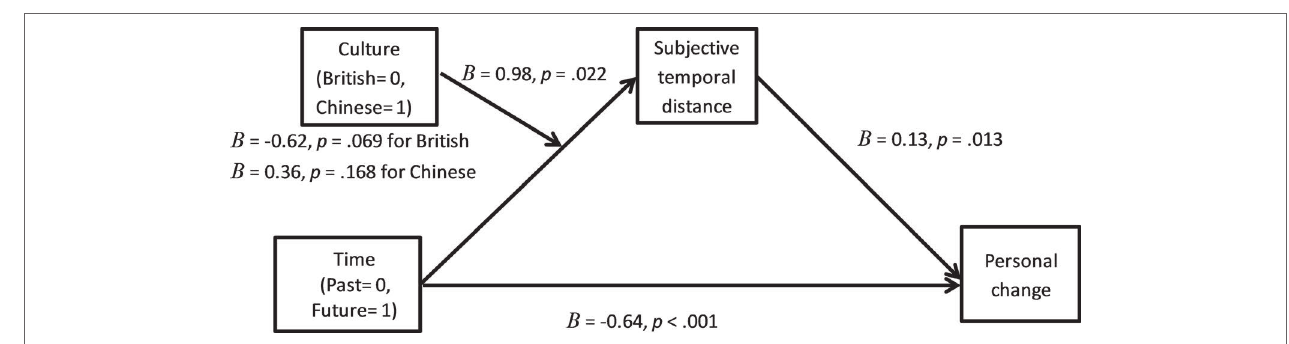
FIGURE 5 | Culture moderated the effect of time condition on subjective temporal distance, which positively predicted personal change.